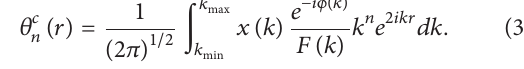
Figure 2: Comparison of the normalized imaginary and magnitude of Fourier transfom (a) ( 𝑘 3 -weighted, 3.0 < 𝑘 < 18 ˚A and amplitude corrected) of EXAFS data at Pt L III edge for Pt foil (black line) and Pt-Ru black (red line), (b) ( 𝑘 3 -weighted, 3.0 < 𝑘 < 18 ˚A Pt-Ru phase and amplitude corrected) of EXAFS data at Pt L III edge for Pt-Ru black , and (c) ( 𝑘 3 -weighted, 3.0 < 𝑘 < 18 ˚A amplitude corrected) of EXAFS data at Ru K edge for Ru foil (black line) and Pt-Ru black (red